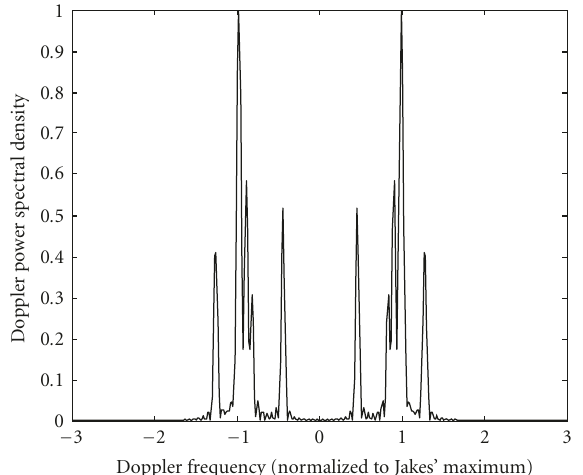
Figure 2: Channel autocorrelation function for proposed elliptical and Jakes’ models.